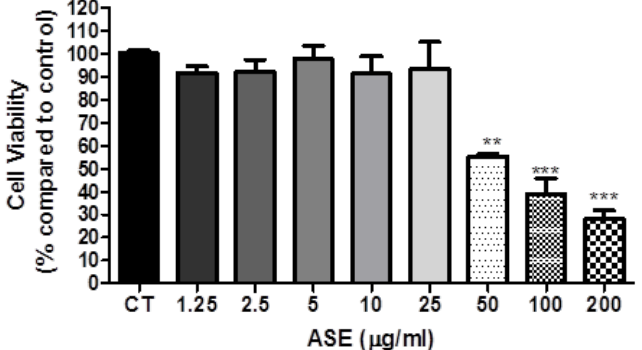
Figure 1. Cell viability of A549 cells treated with açai seed extract (ASE). The cells were treated with ASE (1.25 – 200 µg/mL for 48 h, and the MTT assay was done. The results are expressed as % compared to the control, and expressed as mean 6 standard deviations of 3 independent experiments, each performed with at least 3 replicates. (**, ***) indicates significant differences from the control group (** p < 0.01, *** p < 0.001).